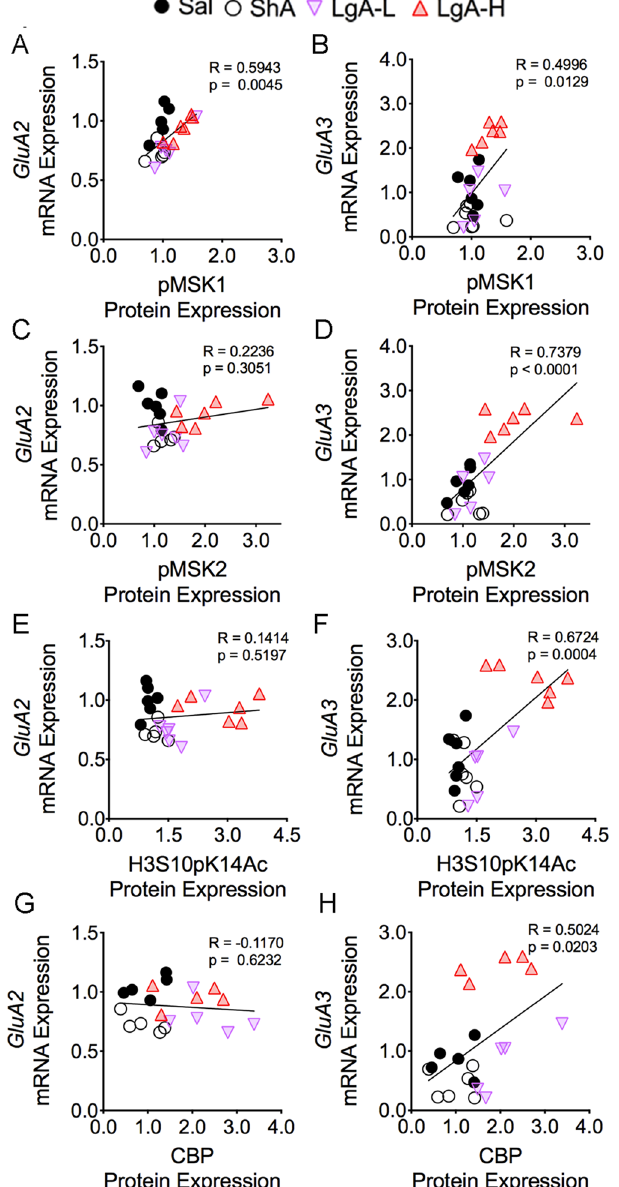
Figure 8. GluA3 mRNA correlated with pMSK1, pMSK2, H3S10pK14Ac, and CBP protein expression. The mRNA expression of GluA2 shows significant linear relationship with ( A ) pMSK1, but not with ( C ) pMSK2, ( E ) H3S10pK14Ac, and ( G ) CBP protein expression . However, the mRNA levels of GluA3 display a positive correlation with the protein abundance of ( B ) pMSK1, ( D ) pMSK2, ( F ) H3S10pK14Ac, and ( H ) CBP (n = 5–6 Sal; n = 5–6 ShA; n = 5–6 LgA-L; n = 5–6 LgA-H). The correlation coefficients and p values are shown on the